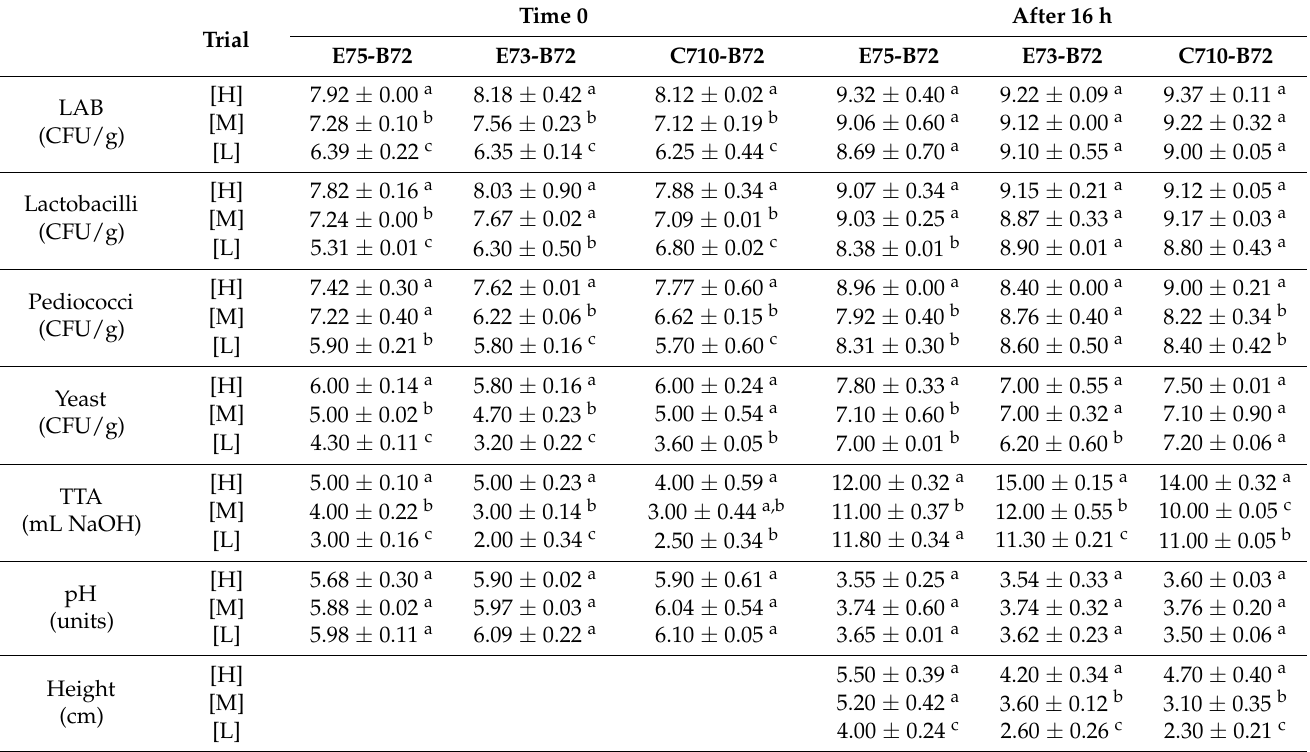
Table 1. Microbial counts, pH, TTA, and height at time 0 and after 16 h of fermentation at 28 ◦ C. LAB and yeast starter inoculated in wheat doughs at about 8 [H], 7 [M], and 6 [L] Log CFU/g. Analyses were performed in triplicate. Results are reported as mean values ± SD. Different superscript letters in a column indicate statistically significant differences (ANOVA: Tukey t -test. p < 0.05.